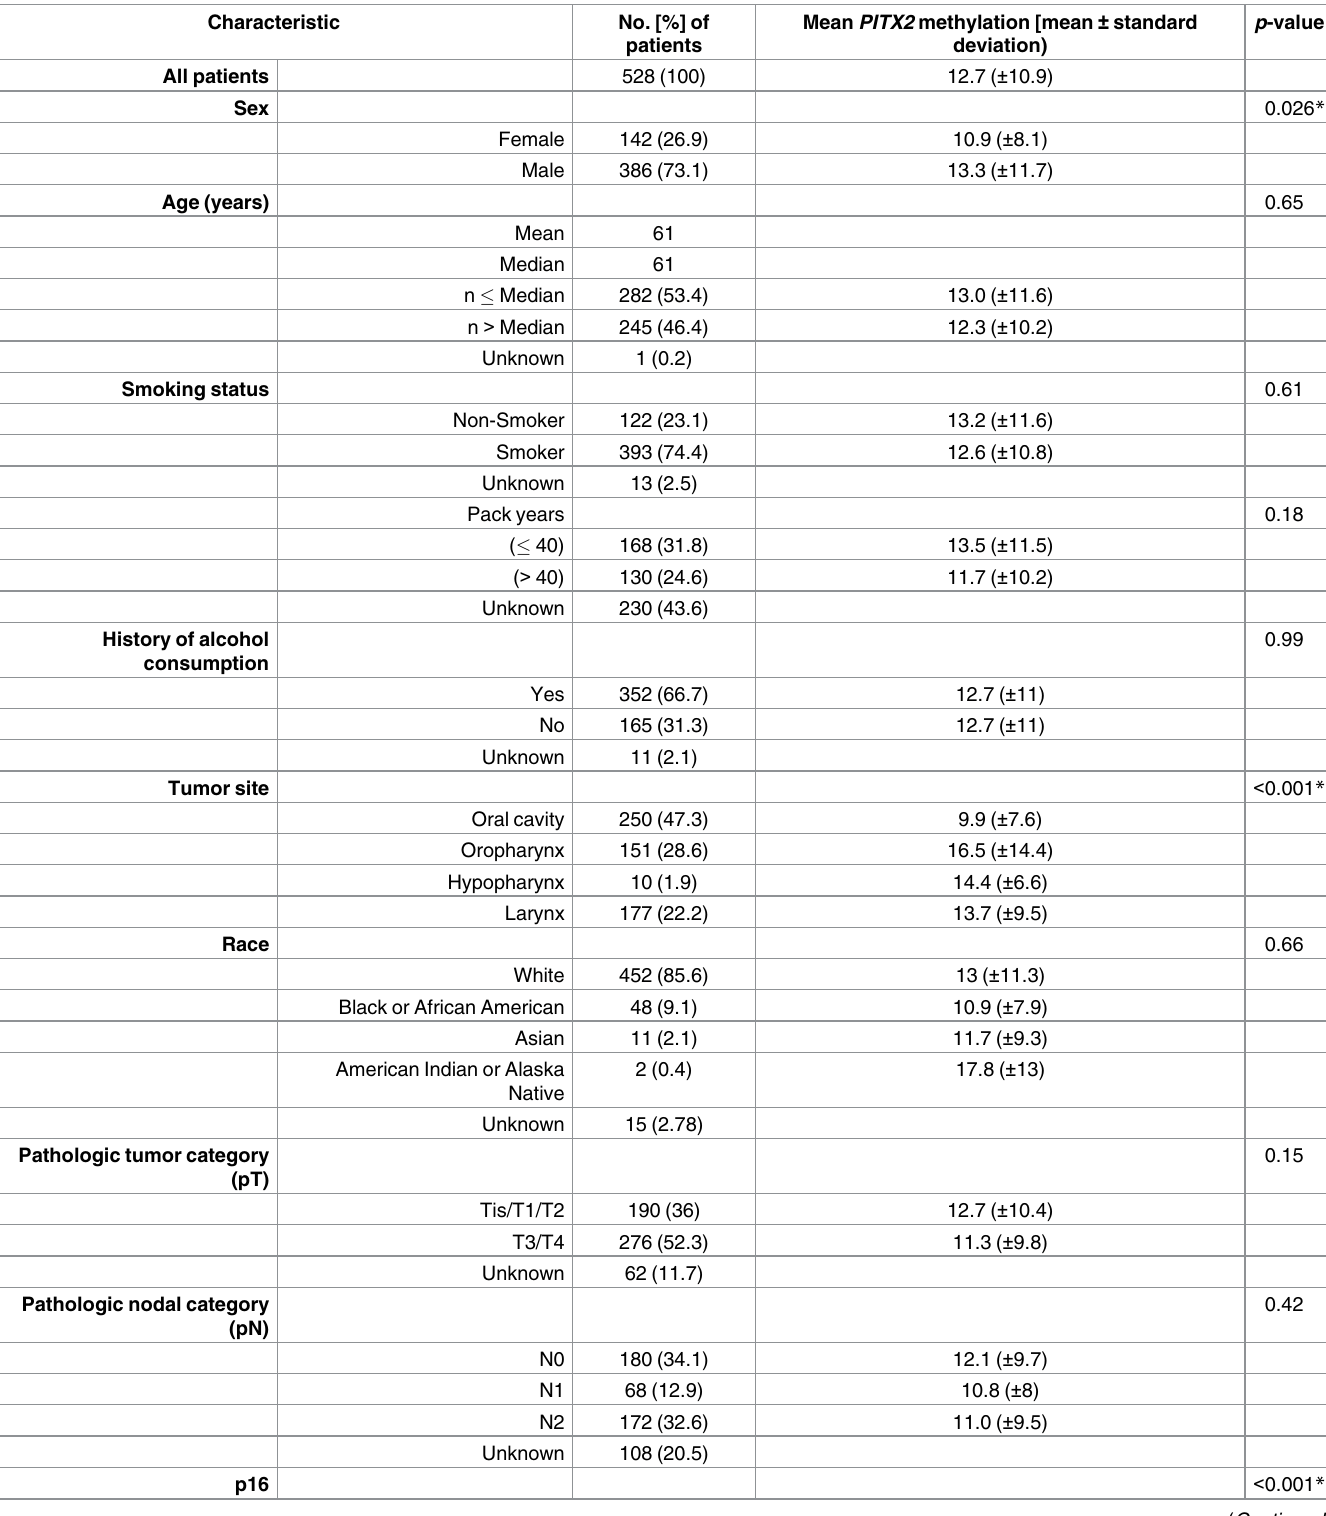
Table 1. Association of PITX2 methylation with clinicopathological characteristics. Associationof PITX2 methylation with clinicopathologicalcharac- teristics in HNSCC patients of the TCGA cohort (n =